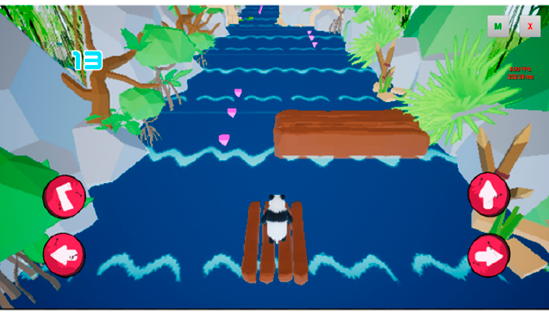
Figure 1. Screenshot of Game .